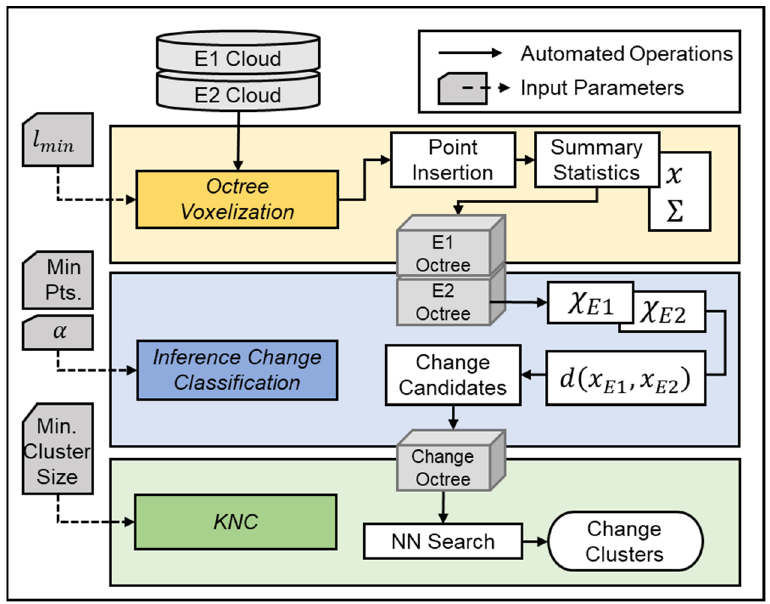
Figure 3. Schematic overview of our octree voxelization, statistical inference-based change detec- tion, and KNC framework showing input parameters, use of octrees, and processing steps. and KNC framework showing input parameters, use of octrees, and processing